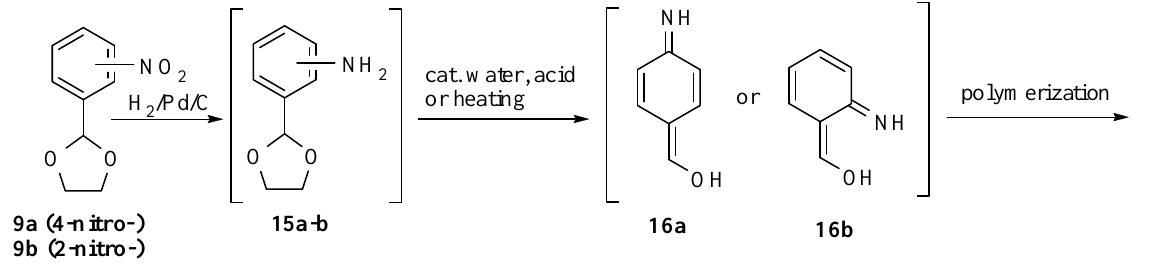
Ethyleneglycol, pTsOH, toluene, ii) H /Pd/C, THF, iii) Ar 1 COCl, K 2 Ar 2 SO NHNH Cl, K CO , CH Cl . 2 3 2 3 2 2 Figure 6. Mechanism proposed for the beginning of polymerization of 2-nitrophenyl-1,3- dioxolane during